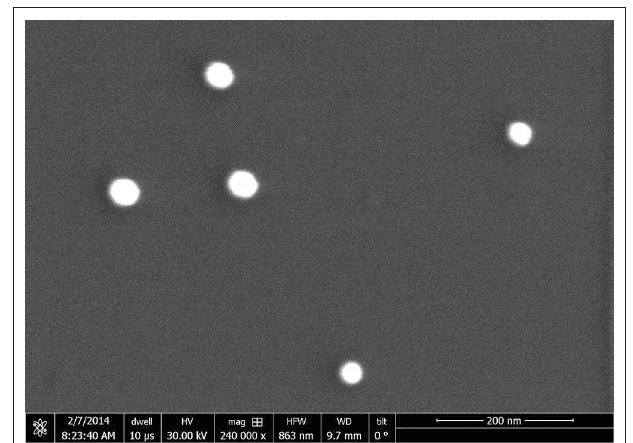
FIGURE 1 | SEM image of citrate covered NPs deposited on a silicon substrate (image taken with e_LiNE plus, Raith, Germany).